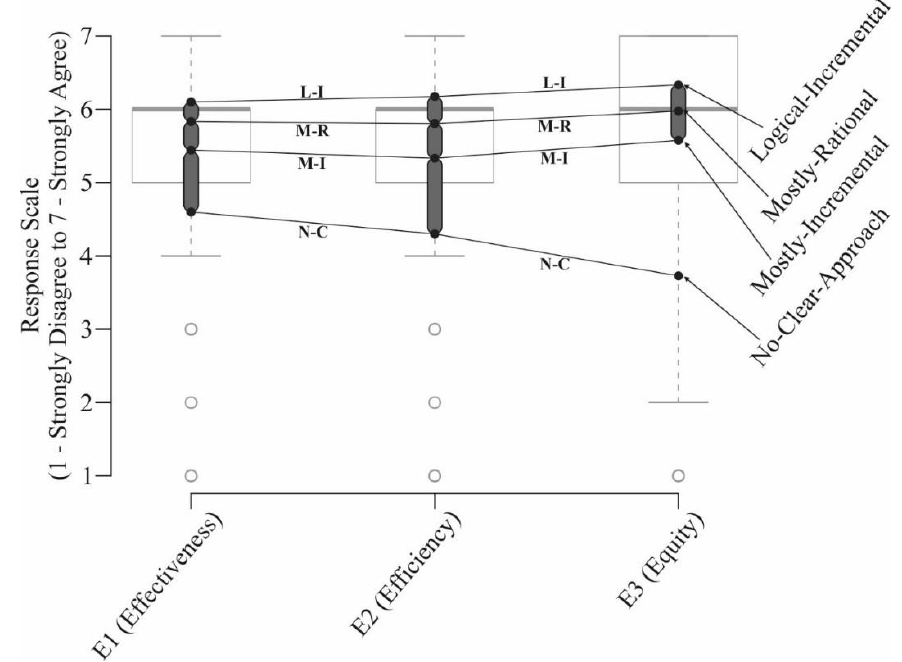
Figure 2. Strategy implementation clusters and perceived performance.